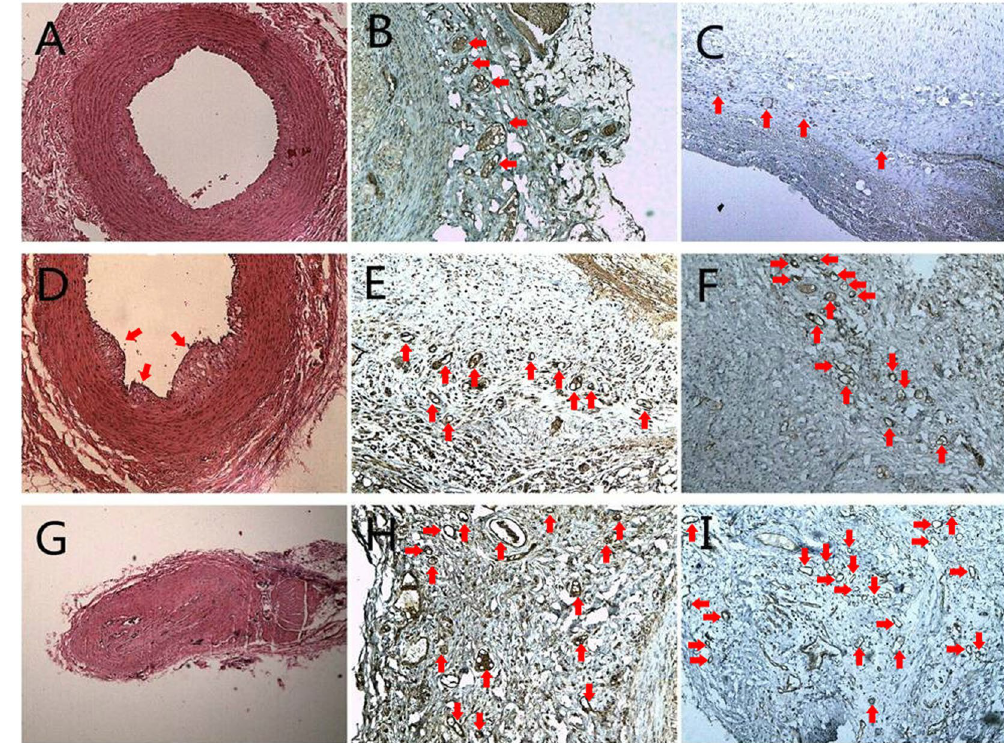
Figure 5. Haematoxylin and eosin stained vessel in early atherosclerosis of the high-fat diet group showed fibre hyperplasia and increased new vessels, × 40 ( A ). Immunohistochemical stain for VEGF of the same vessel showing increased adventitial microvessels, × 100 ( B ). Immunohistochemical stain for CD31 of the same vessel showing many adventitial microvessels, × 100 ( C ). Haematoxylin and eosin stained vessel showing a small plaque in group 4, × 40 ( D ). Red arrowheads indicate immunohistochemical stain for VEGF of the same vessel showing many adventitial microvessels, × 100 ( E ). Immunohistochemical stain for CD31 of the same vessel showing many adventitial microvessels, × 100 ( F ). Haematoxylin and eosin stained vessel showing advanced plaque leading to lumen occlusion in group 5, × 40 ( G ). Immunohistochemical stain for VEGF of the same vessel showing numerous adventitial microvessels, × 100 ( H ). Immunohistochemical stain for CD31 of the same vessel showing numerous adventitial microvessels, × 100 ( I ). The red arrowheads in B , C , E , F , H and I indicate